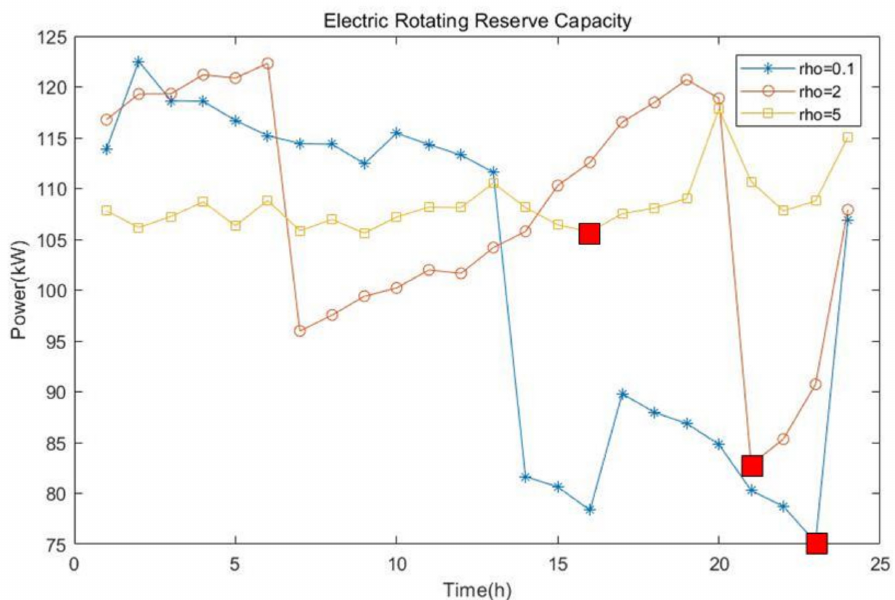
Figure 9. Influence of Risk Preference Coefficient on Electric Rotating Reserve